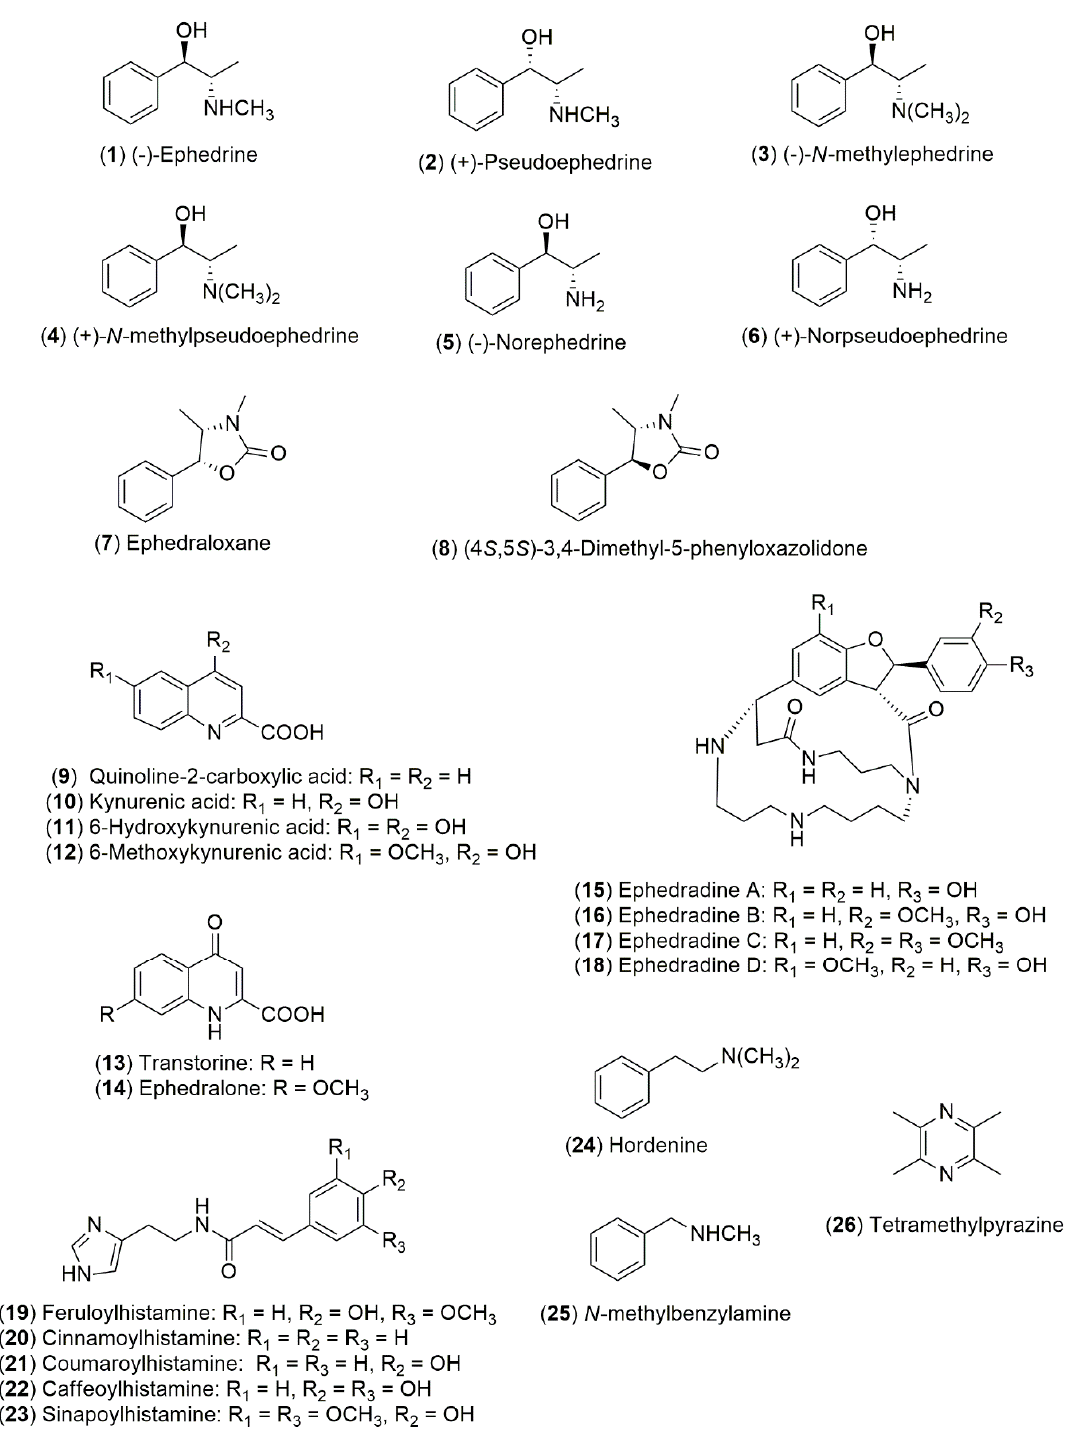
Figure 1. Structures of alkaloids from Ephedra species.